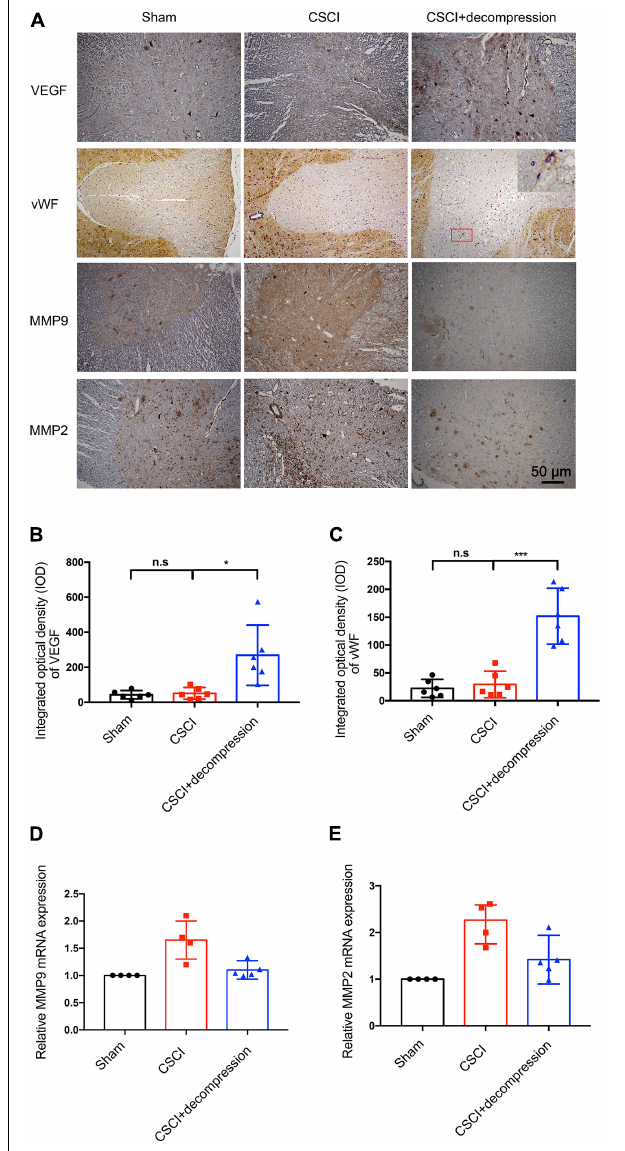
FIGURE 4 | Decompression promoted VEGF and vWF expression and inhibited MMP-9 and MMP-2 expression. (A) VEGF, vWF, MMP-9, and MMP-2 expression was assessed by IHC (200 × magnification; scale bar, 50 µ m). IHC staining of (B) VEGF [One-way ANOVA, F (1.021,5.103) = 10.12, p = 0.024; Tukey post hoc : n.s.: not significant; * p = 0.045] and (C) vWF [One-way ANOVA, F (1.075,5.376) = 29.33, p = 0.002; Tukey post hoc : n.s.: not significant; *** p < 0.001] as quantitated by analyzing the IOD. Relative expression of (D) MMP-9 and (E) MMP-2 as assessed by RT-qPCR. IHC: n = 6 each group. Mean ± 95% CI; RT-qPCR: the Sham group: n = 4; CSCI group: n = 4; CSCI with decompression group: n = 5; Medians ± interquartile ranges, the sample size was too low to perform statistics for these